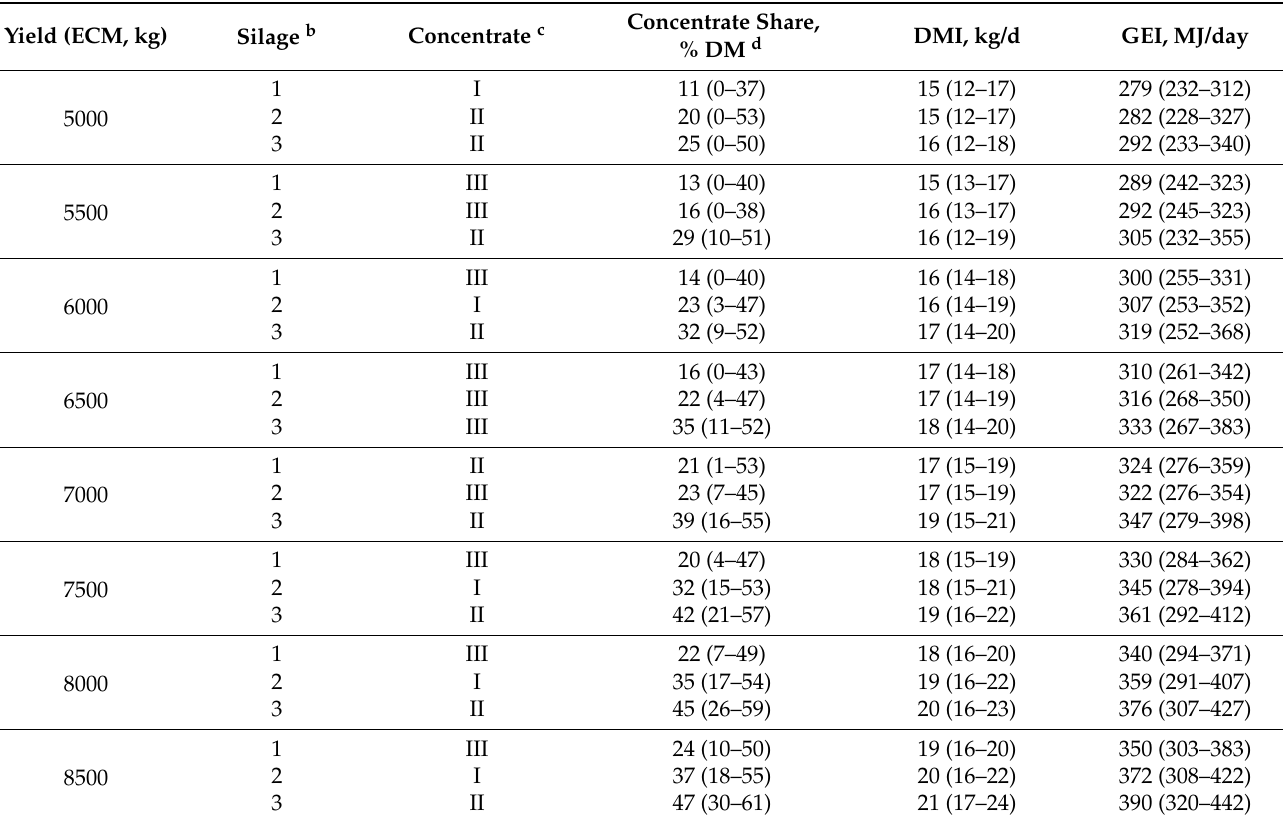
Table 2. Mean (min-max) value of concentrate share, dry matter intake (DMI) and gross energy intake (GEI) throughout a 305-day lactation with various combinations of silages and concentrates at different levels of energy corrected milk (ECM) production a in the NorFor-database used for the operational models. Yield (ECM,